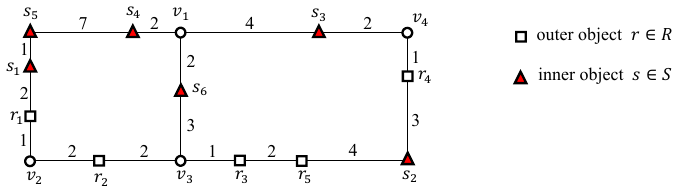
Figure 3. Example of an ε -distance join query in a road network.